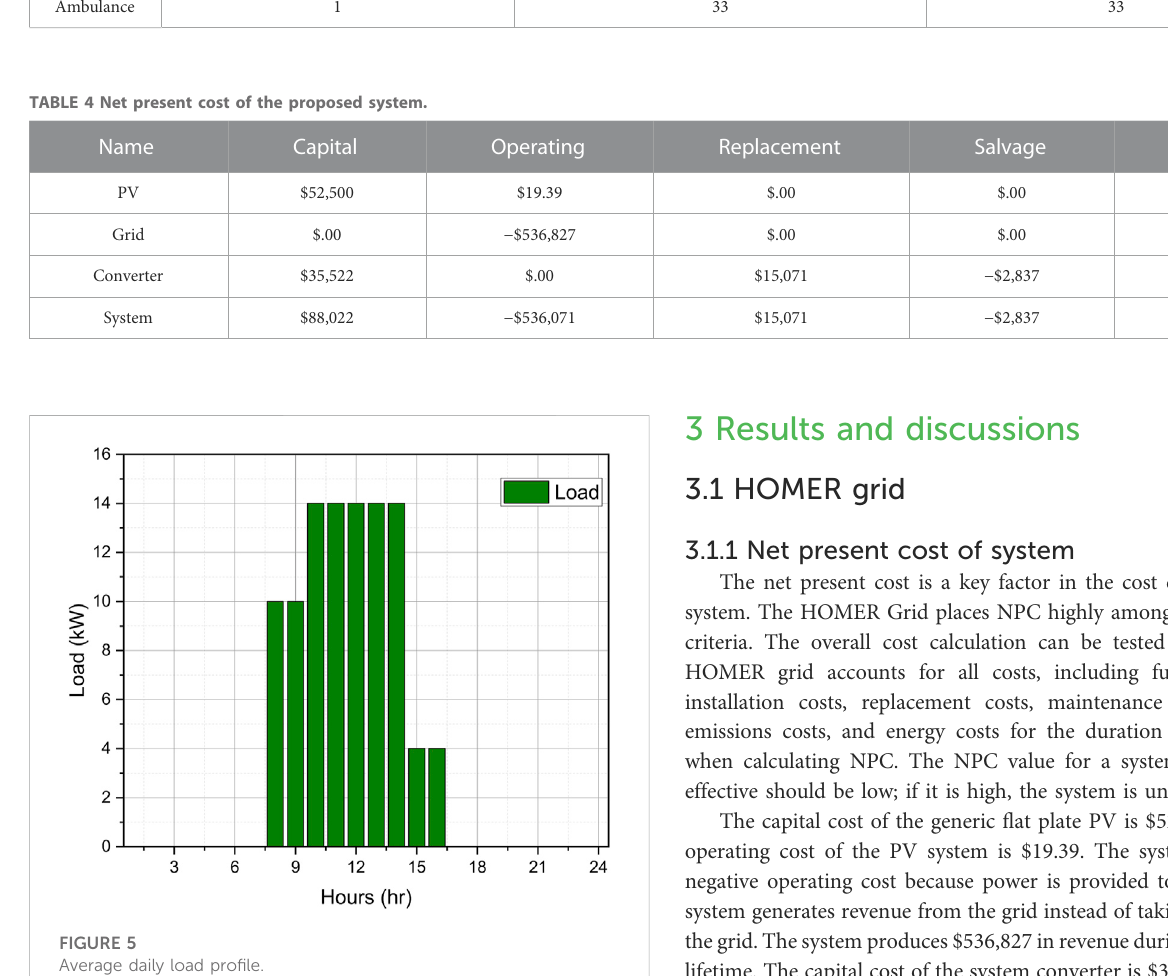
FIGURE 5 Average daily load pro fi